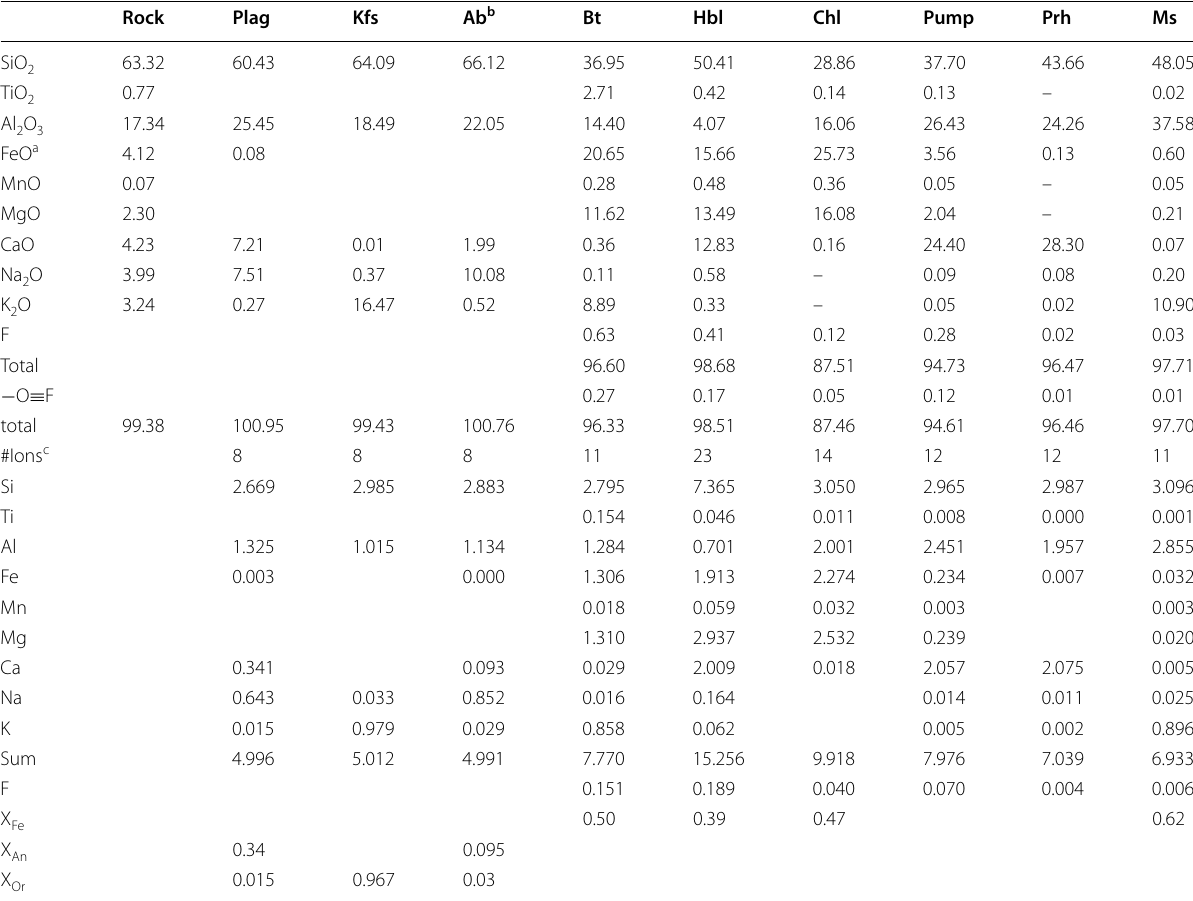
Table 3 Composition of rock and minerals of Qz-monzodiorite in the open hole section of